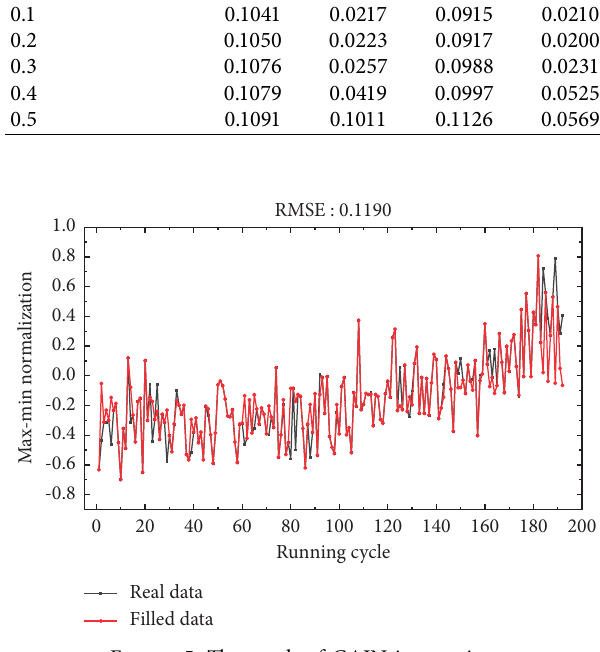
Figure 5: The result of GAIN imputation.